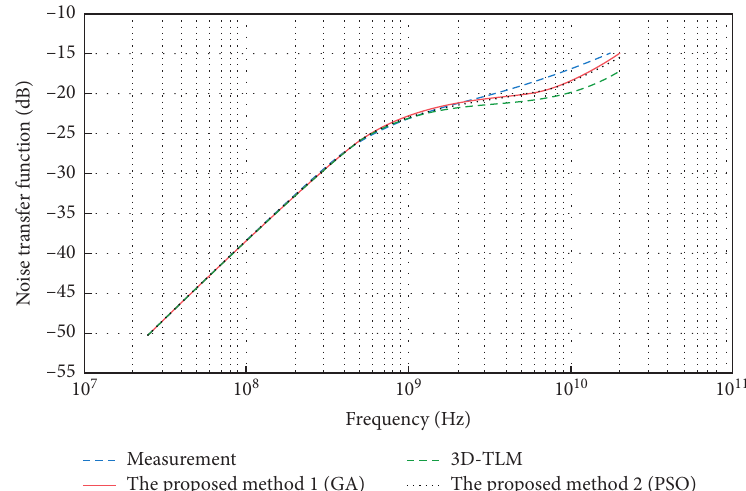
Figure 12: The proposed method, measured, and 3D-TLM noise transfer function of TSV-TSV noise coupling.